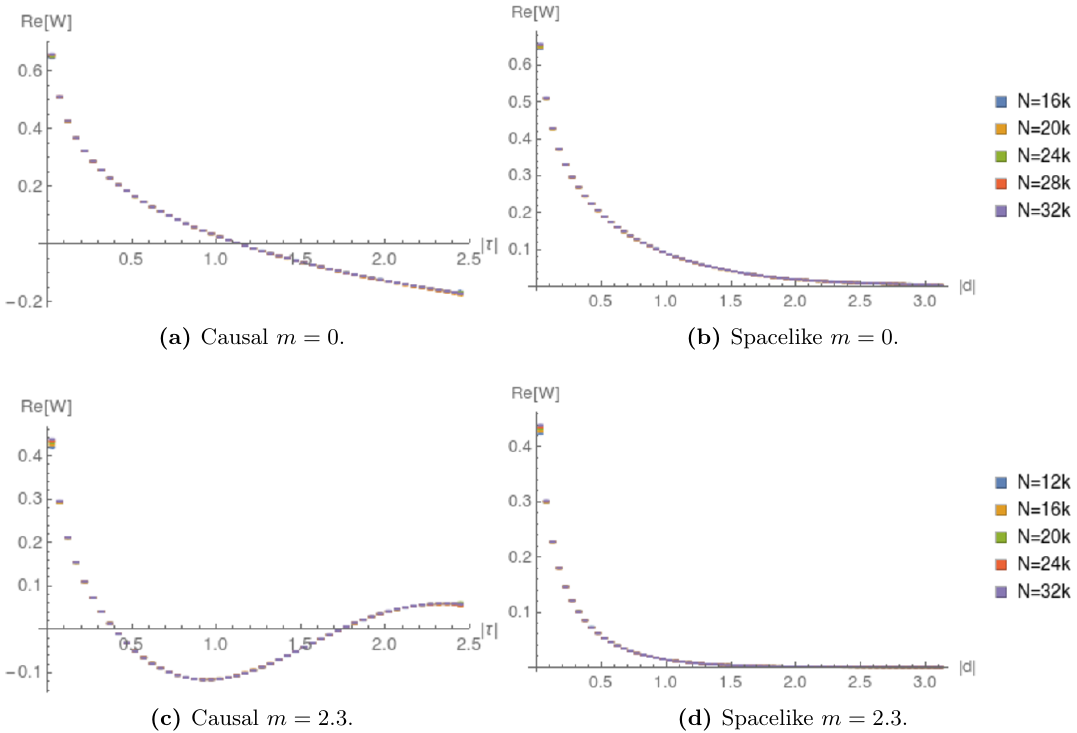
Figure 17. Variation of binned and averaged Re[ W